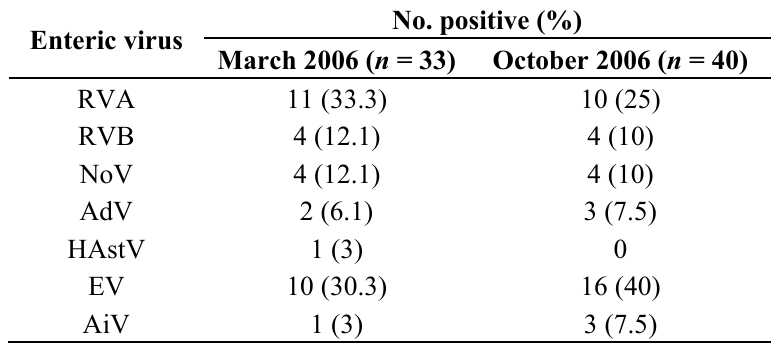
Table 1. Distribution of single enteric viruses detected in the outbreak cases of gastroenteritis.